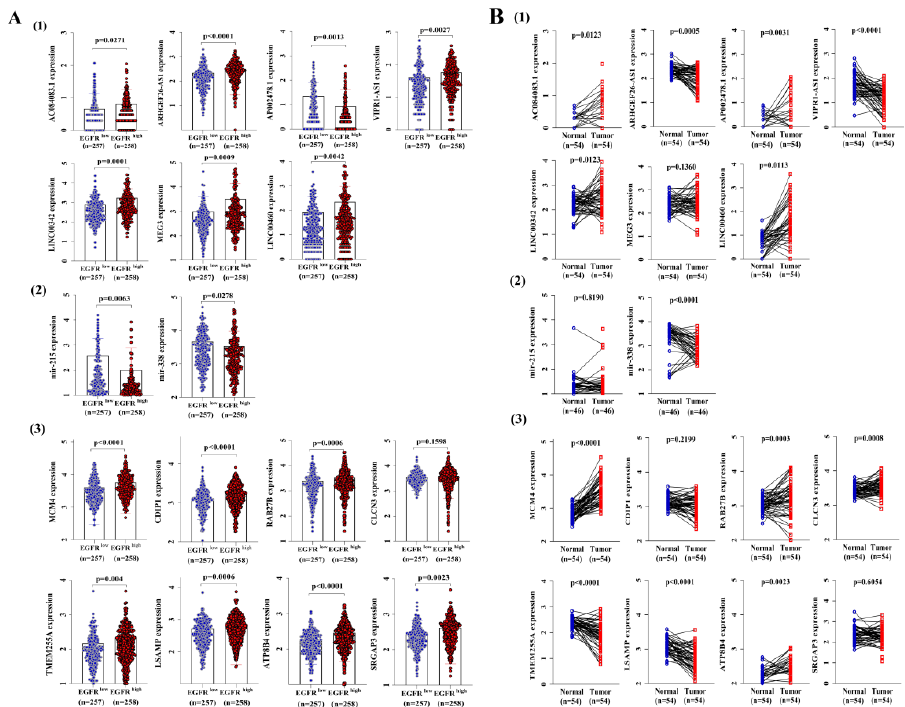
Figure 4. The distribution of 17 RNAs’ expression values from the ceRNA network in the TCGA LUAD dataset. ( A ) The expression of 17 RNAs in LUAD samples with EGFR high and EGFR low expression groups. ( B ) The distribution of 17 RNAs’ expressions in paired LUAD tissues. The RNAs’ expression values were logarithmized with log10. Statistically significant differences between the two groups of data were estimated by an independent t -test. A p < 0.05 was considered statistically significant.